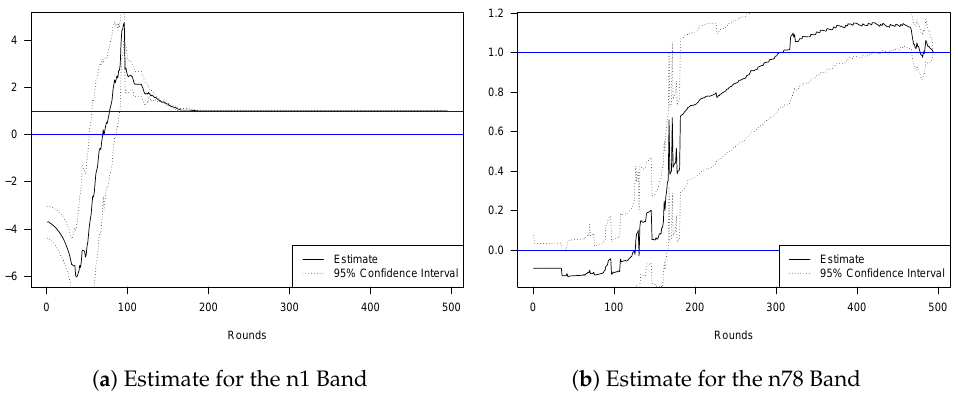
Figure 6. Sample Split by Frequency Band . The graph shows the OLS estimate for ˆ β t for each point during the auction for the n1 (2 GHz) Band in Panel ( a ) and the n78 (3.6 GHz) Band in Panel ( b ). The two blue lines indicate the noise hypothesis ( β = 0) and the learning hypothesis ( β = 1). The dotted lines represent the 95%-confidence interval based on robust standard